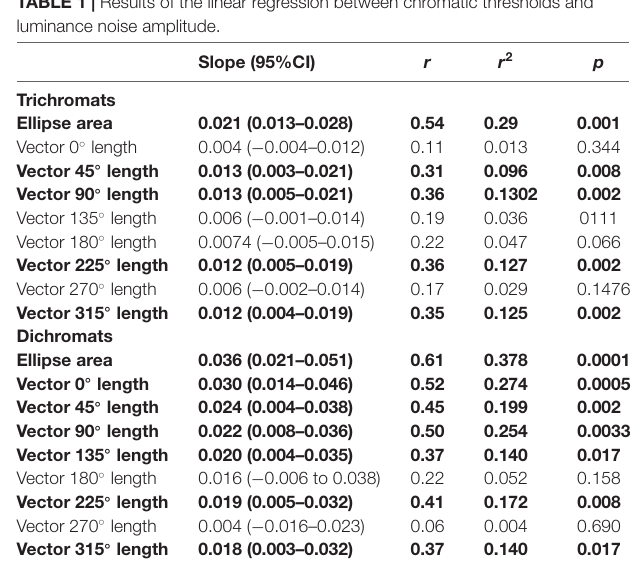
95% CI: 95% confidence interval; r = correlation coefficient; r 2 = coefficient of determination; p = p-value. Significant values are in